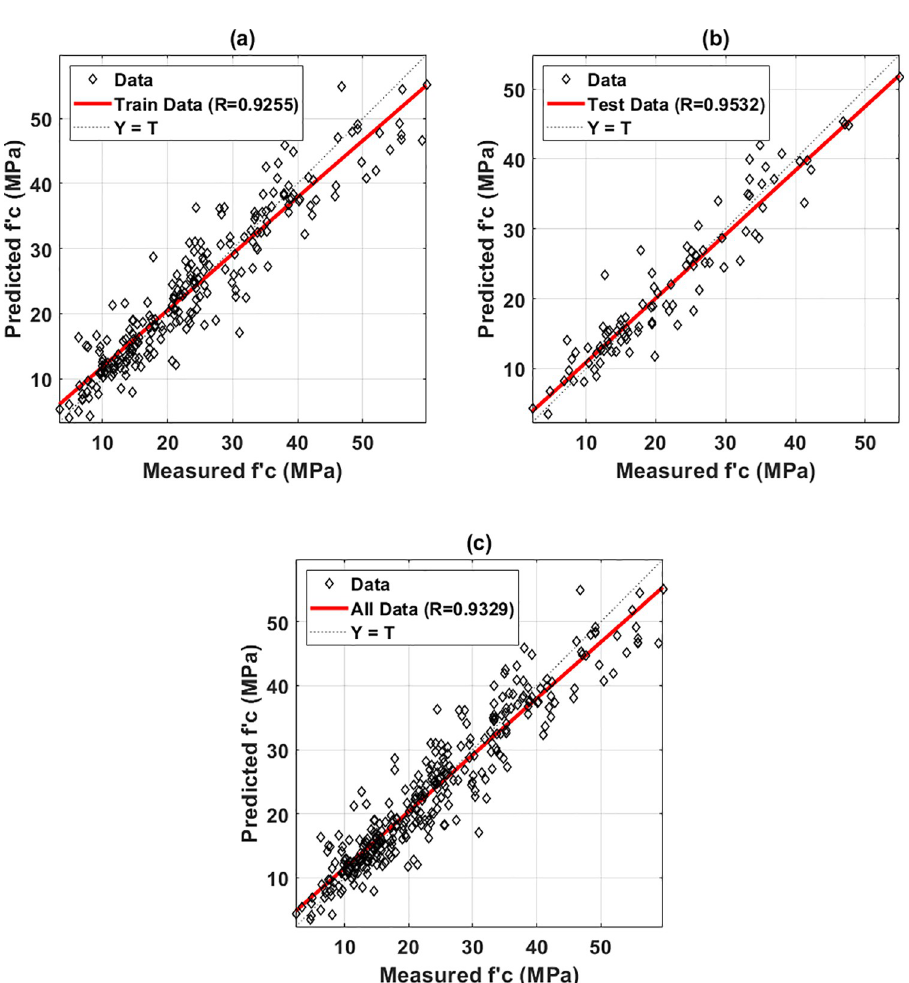
Fig 3. Regression graphs for the measured and predicted values of early compressive strength of HPC for (a) the training dataset; (b) testing dataset; and (c) all dataset. https://doi.org/10.1371/journal.pone.0262930.g003 black lines) were also plotted in each case to demonstrate the GPR model’s performance. Table 1 illustrates the various error criteria used to compare predicted and experimental values of early compressive strength for both training and testing sets. High correlation values were obtained for both the training dataset (R = 0.9255) and the testing dataset (R = 0.9532). Besides, the values of standard deviation error were 4.8703 and 3.3790 for the training, and testing dataset, respectively. Thus, it can be seen that the performance of the testing dataset was superior to the training one, which might come from the samples that constituted these